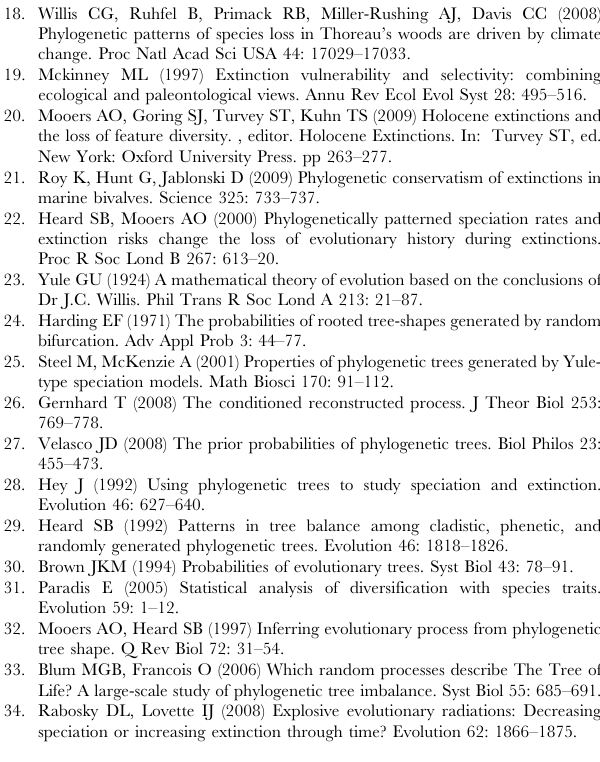
confidence interval with a sample size of 1000 trees. Note differences in vertical axes. (TIFF) Figure S5 The additional loss of PD as function of phylogenetic clustering in 64-tip unbalanced Yule trees. A) mean p(ext) =0.25, B) mean p(ext) = 0.5, and C) mean p(ext) = 0.75. Data points in percentage denote the amount of additional loss of projected PD (relative to random extinction) with increasing phylogenetic clustering. Dashed line indicates that loss under random extinction. Error bars around points represent the 95% confidence interval with a sample size of 1000 trees. Note differences in vertical axes. (TIFF) Figure S6 Percentage difference in projected PD as a function of phylogenetic clustering in 64-tip coalescent trees. A) mean p(ext) = 0.25, B) mean p(ext) = 0.5, and C) mean p(ext) = 0.75. Data points in percentage denote the amount of additional loss of projected PD (relative to random extinction) with increasing phylogenetic clustering. Dashed line indicates that loss under random extinction. Error bars around points represent the 95% confidence interval with a sample size of 1000 trees. Note differences in vertical axes.